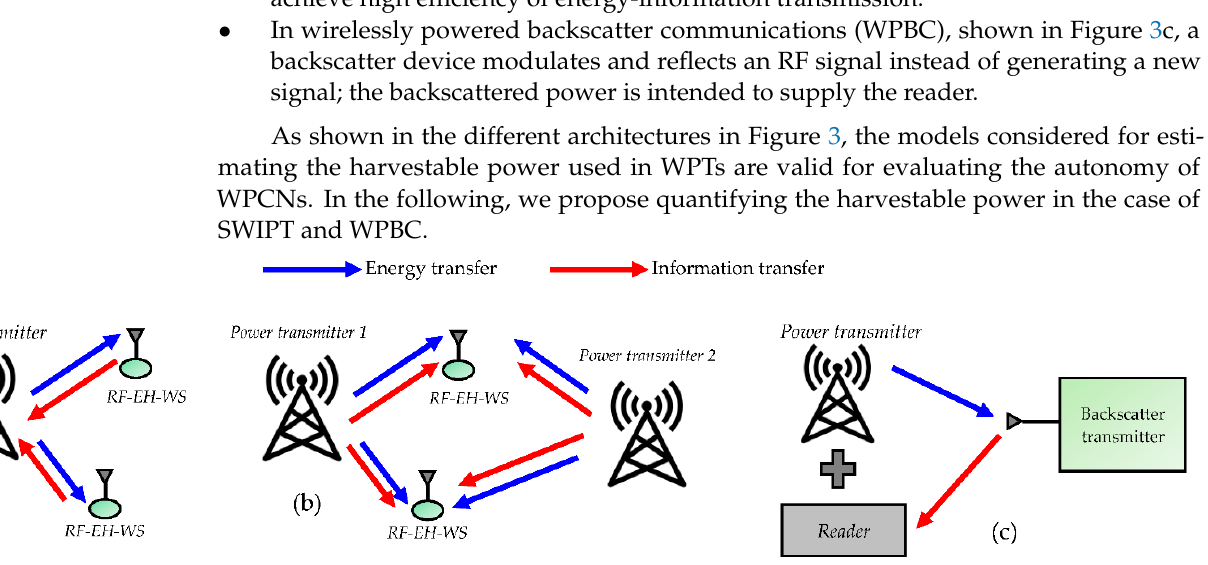
Figure 3. Various WIPT architectures. ( a ) WPCN. ( b ) SWIPT. ( c )